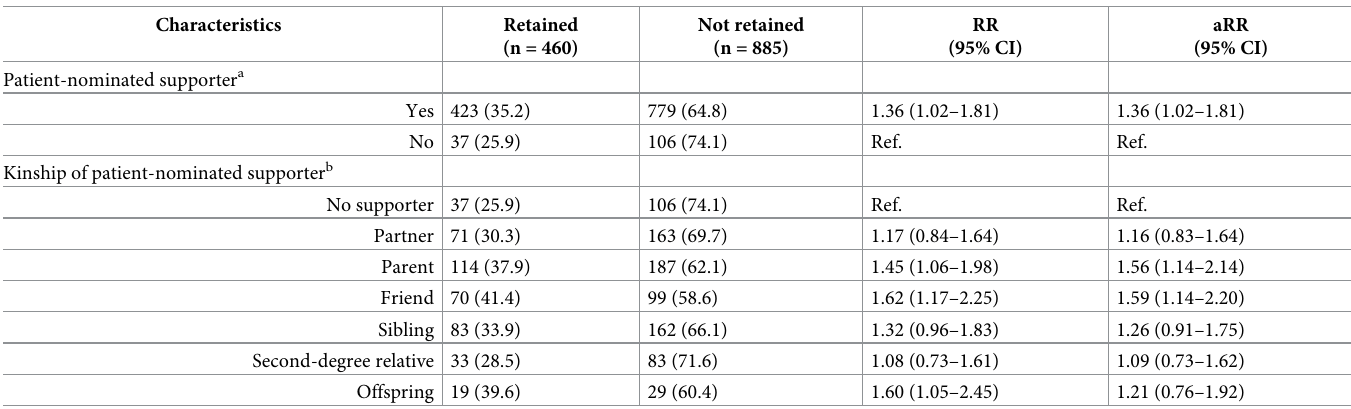
Table 4. Associations between having patient-nominated supporters and being retained in care after two years among people living with HIV, 2011–2014.